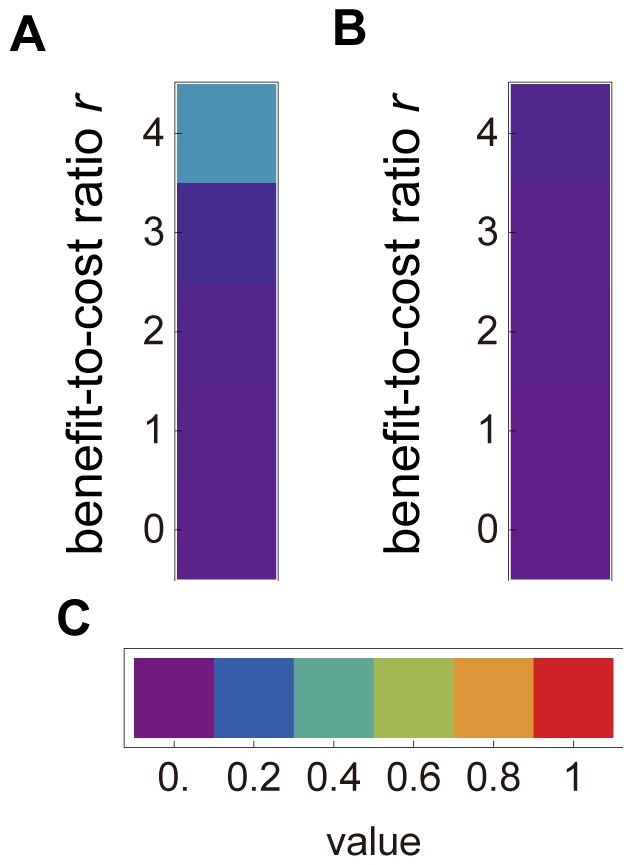
Effectiveness of public goods (r) and evolution of cooperation level without punishment.(A) and (B) present the cooperation level after 1,000,000 generations in the spatially structured condition and the random-matching condition, respectively. Other conditions are the same as noted in the main text. Each data block is the average of 50 trials. (C) presents the relationship between a value and color in both (A) and (B).